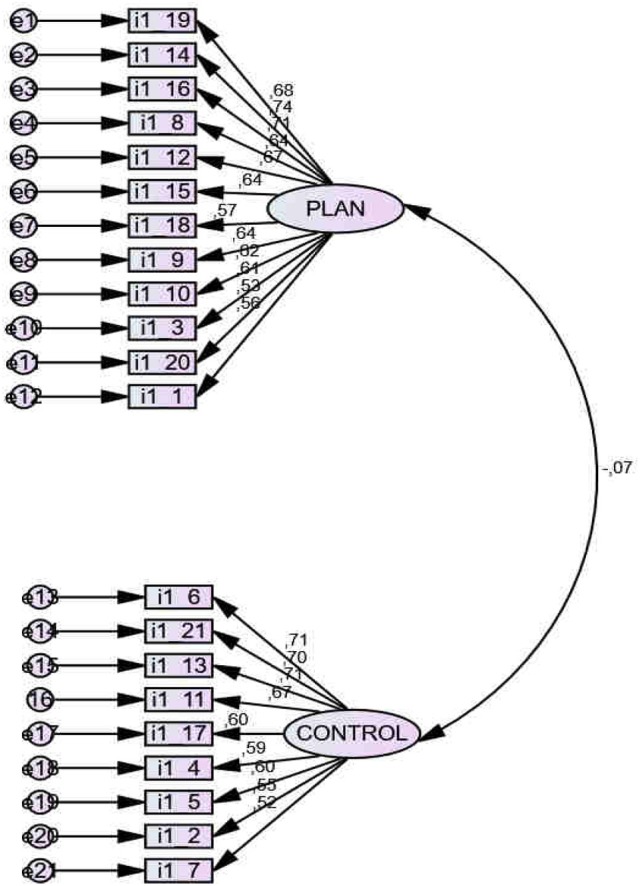
Confirmatory Factor Analysis (CFA) of the SRQ-21 scale.